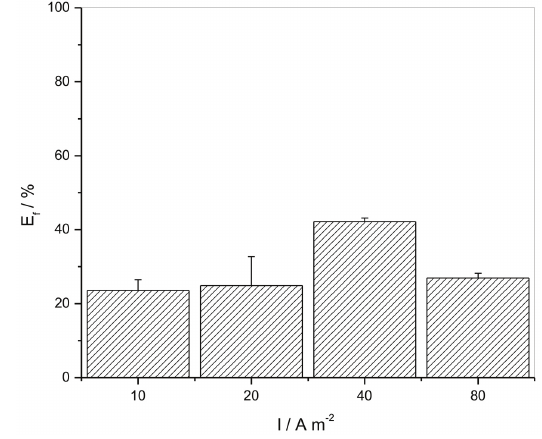
Figure 3. Average values of cathodic efficiency ( E alloy on steel substrate.